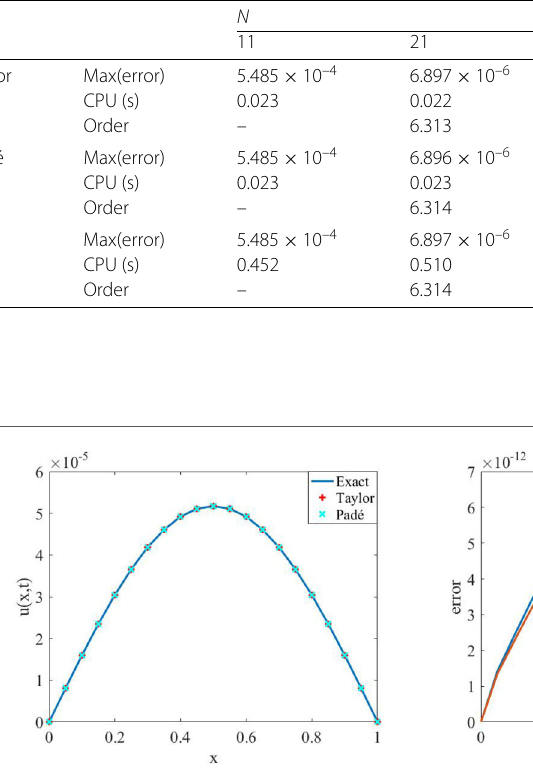
Figure 8 The exact solutions and two numerical solutions (on left-hand side figure) and the errors between Taylor approximation and Padé approximation (on right-hand side figure) with N = 21 for case 3 of Example 1